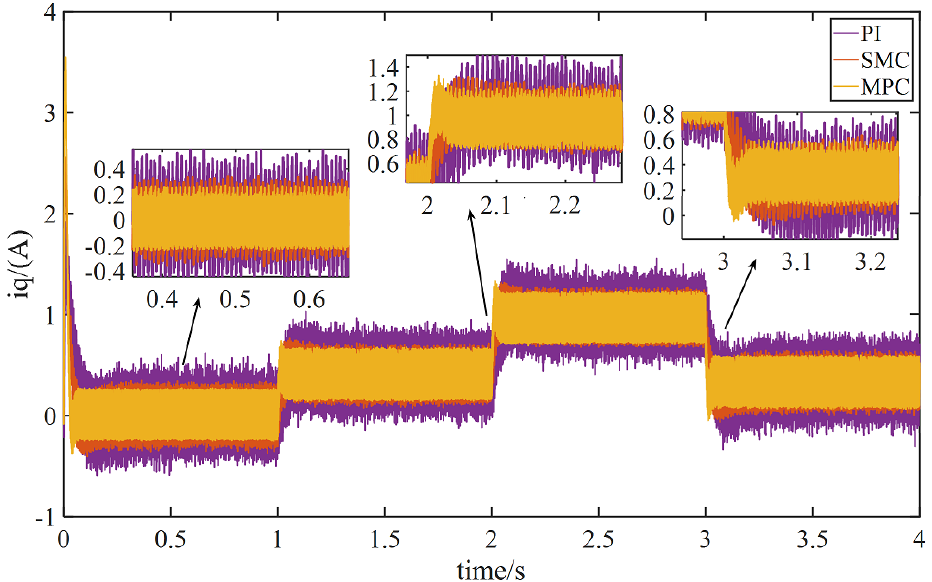
Figure 9. Comparison of the current waveforms of the three systems.